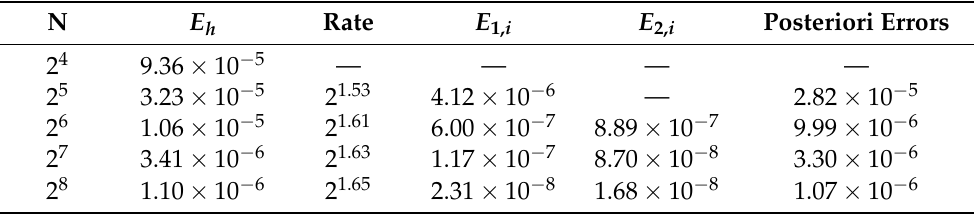
Table 3. Numerical results at t = 0.4 of Example 3.